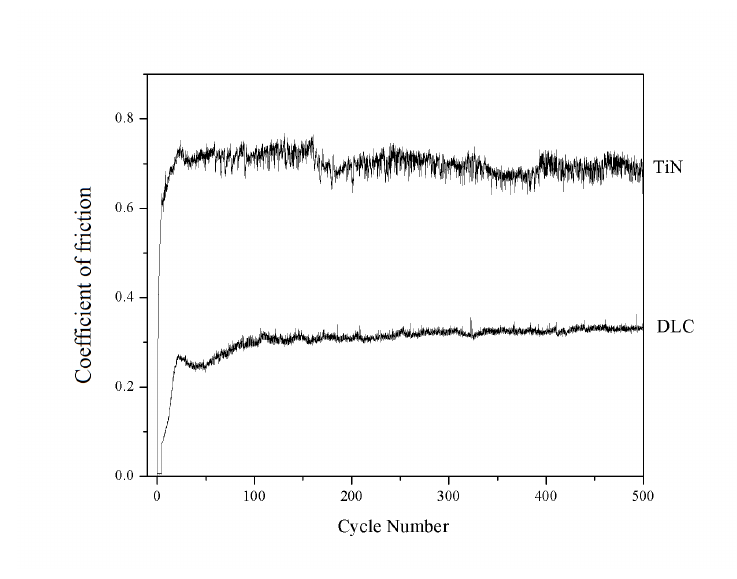
Figure 8. Coefficient of friction for TiN and DLC.